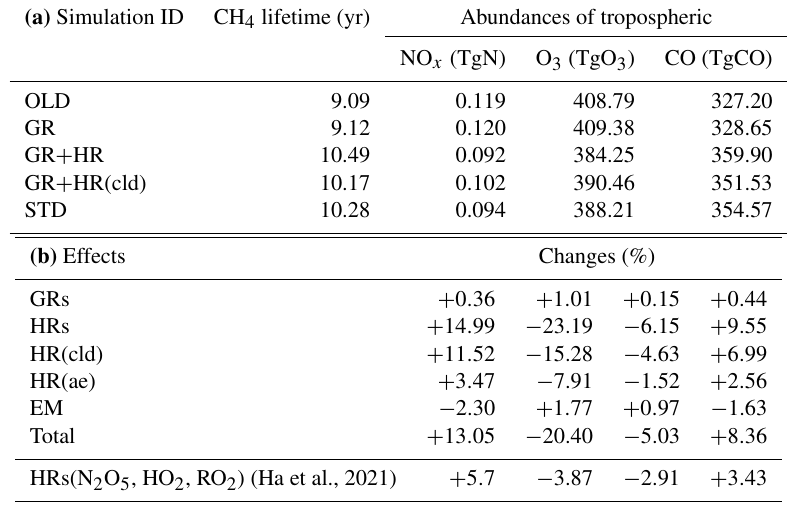
Table 9. CH 4 lifetime and tropospheric abundances for NO x , O 3 , and CO and the changes by HONO chemistry.